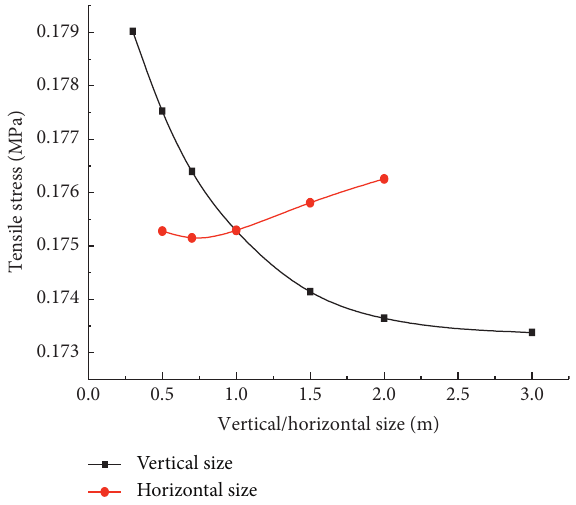
Figure 20: The effect of horizontal/vertical size on tensile stress of patch block.